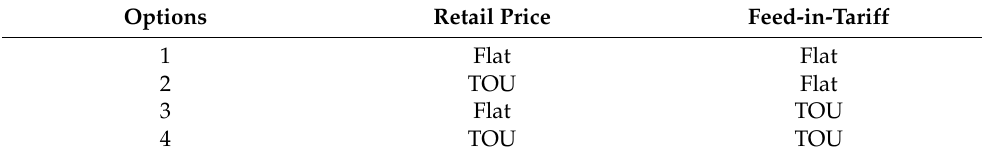
Table 5. Different options based on the type of the electricity rate for retail price and feed-in-tariff. Options